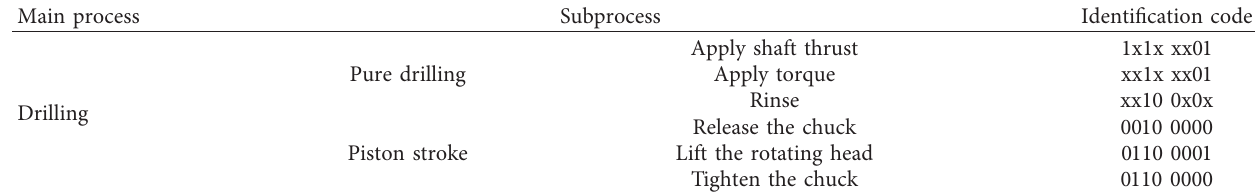
Table 5: Identification code of the drilling process.